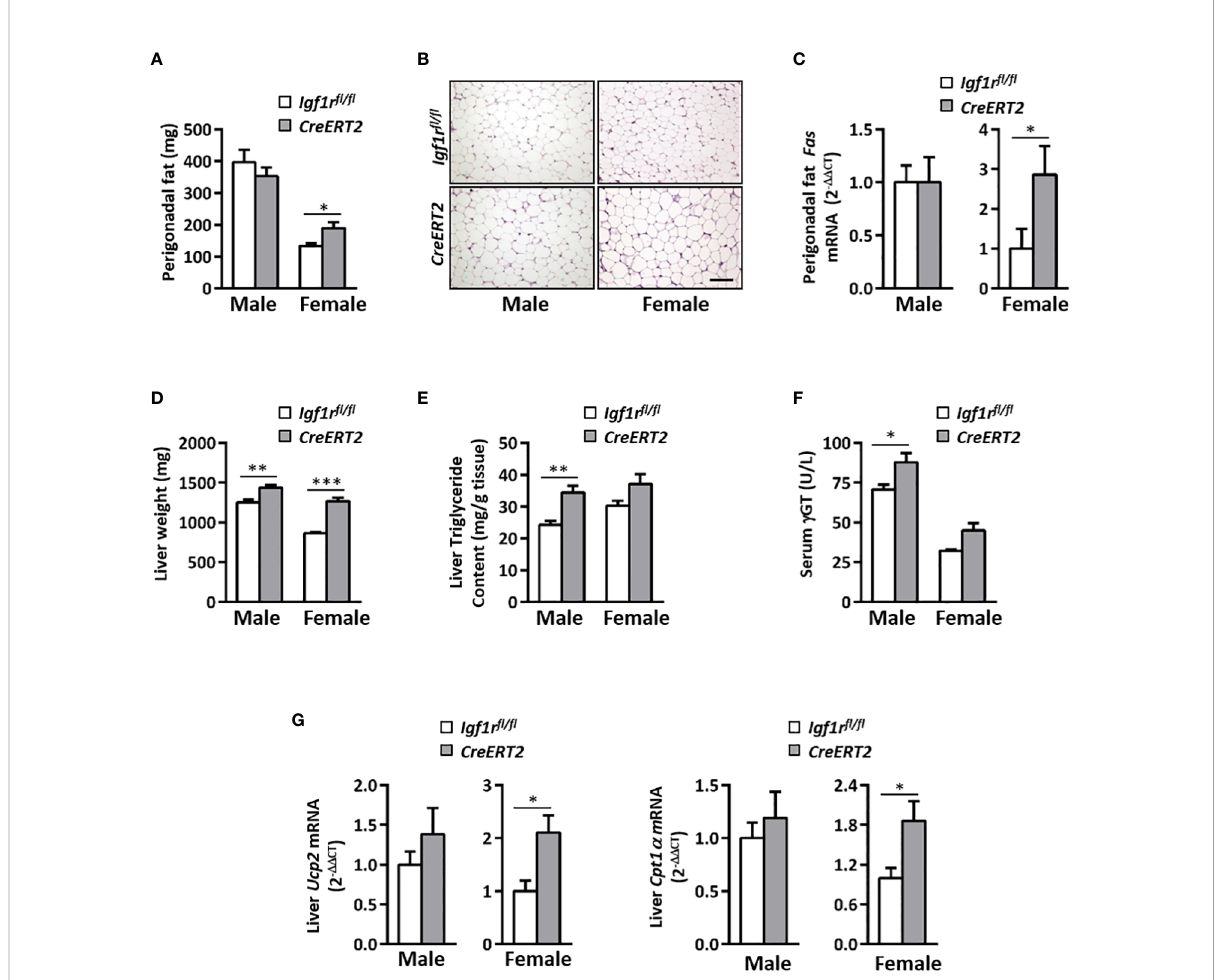
FIGURE 4 Impact of IGF1R de fi ciency on perigonadal adipose tissue and liver in young animals. (A) Effects of IGF1R depletion on perigonadal fat weight in 13 weeks-old CreERT2 mice. (B) Representative H&E staining of epididymal (males) and periovarian (females) fat depots. Scale bar, 100 µm. (C) Perigonadal fatty acid synthase ( Fas ) mRNA levels. Gene expression is expressed as fold changes (2 - DD Ct ) compared to its Igf1r fl / fl corresponding controls, considered as 1. (D) Liver weight. (E) Liver triglyceride content. (F) Gamma-glutamyltransferase ( ƴ GT) circulating levels. (G) Liver uncoupling protein 2 ( Ucp2 ) and carnitine palmitoyl-transferase 1 a ( Cpt1 a ) mRNA levels expressed as fold changes (2 - DD Ct ) and compared to their Igf1r fl / fl corresponding controls, considered as 1. Data are expressed as mean ± SEM of at least 4 animals per group (n= 4-14 mice per group). *p < 0.05, **p < 0.01 and ***p < 0.001 vs . Igf1r fl / fl corresponding